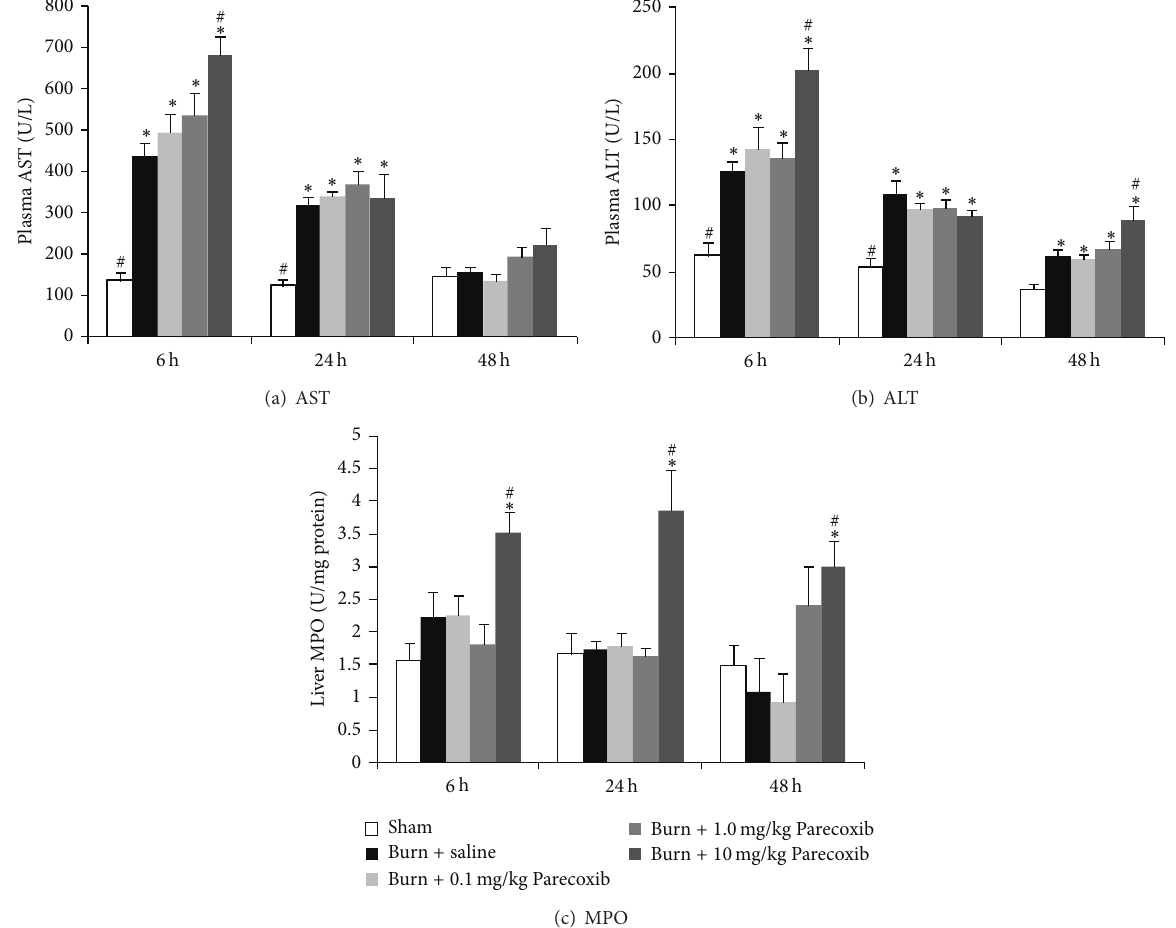
Figure 4: Changes in parameters for liver function over 48 h after burn injury. (a) AST; (b) ALT; (c) MPO. ∗ Significantly different from Sham group. # Significantly different from burn + saline group ( 𝑃 < 0.05 , one-way ANOVA, Bonferroni post-hoc